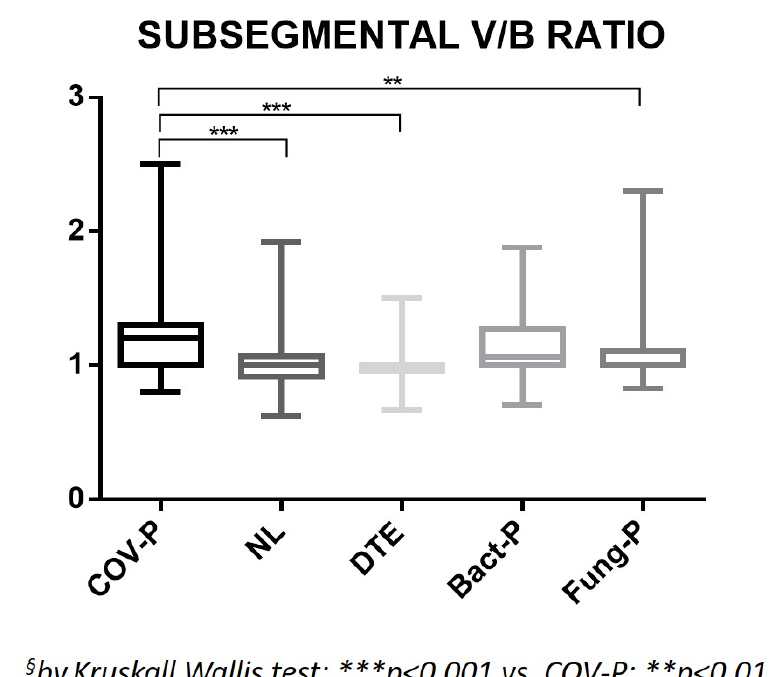
Figure 4. Ratio between the caliber of the subsegmental branches of the pulmonary arteries and their corresponding bronchial branches, measured on healthy lung parenchyma. COV-P, COVID-19 pneumonia; NL, normal lung; DTE, distal thromboembolism; Bact-P, bacterial pneumonia, Fung-P, fungal pneumonia.